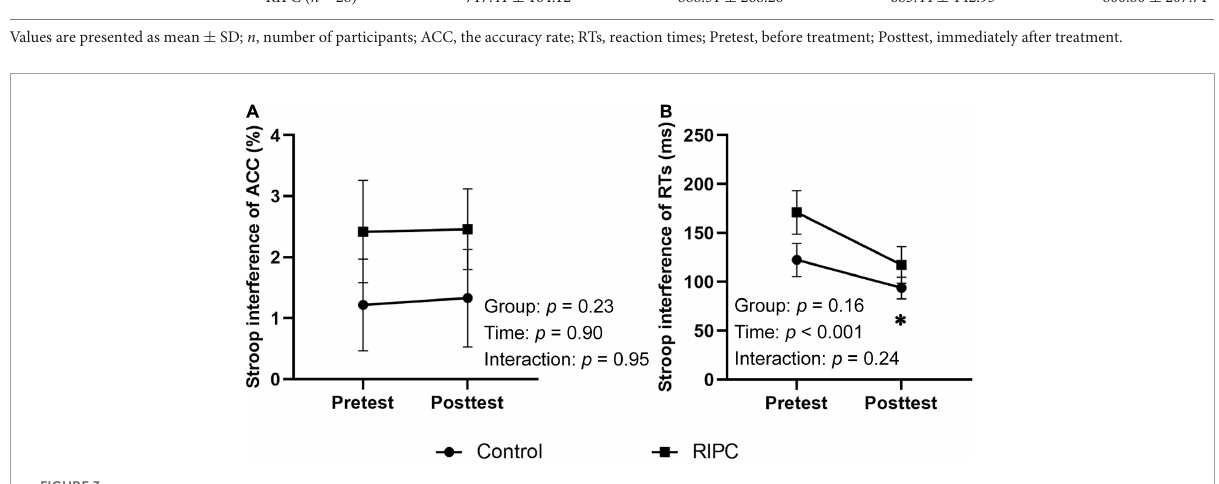
FIGURE3 Behavioral results of two groups. (A) Stroop interference effect of ACC. (B) Stroop interference effect of RTs. Error bar represents the stand error; ACC, the accuracy rate; RTs, reaction times; Pretest, before treatment; Posttest, immediately after treatment. ∗ Significant difference ( P < 0.001) between time